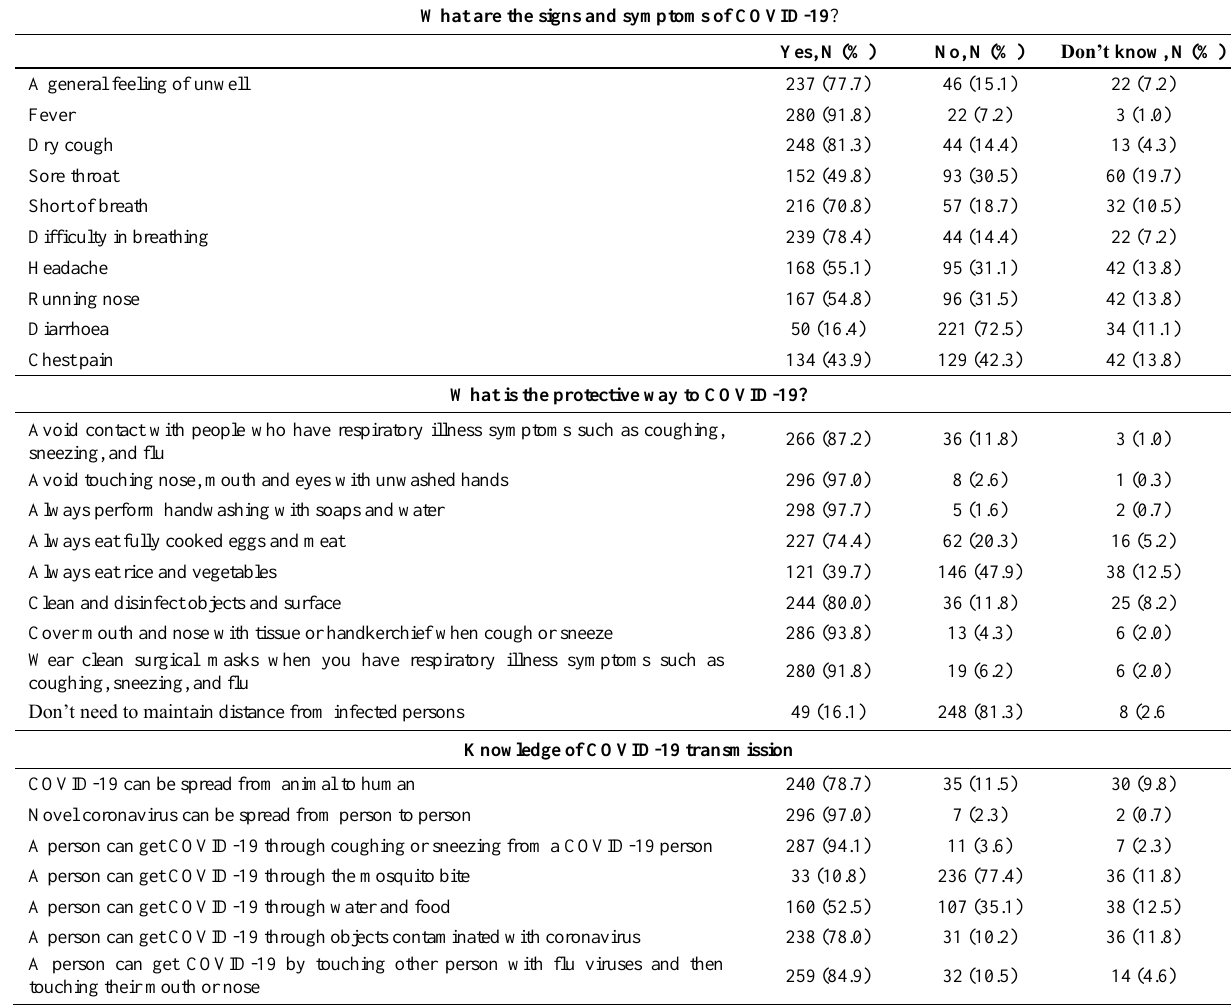
Table 1. General knowledge of COVID-19 among